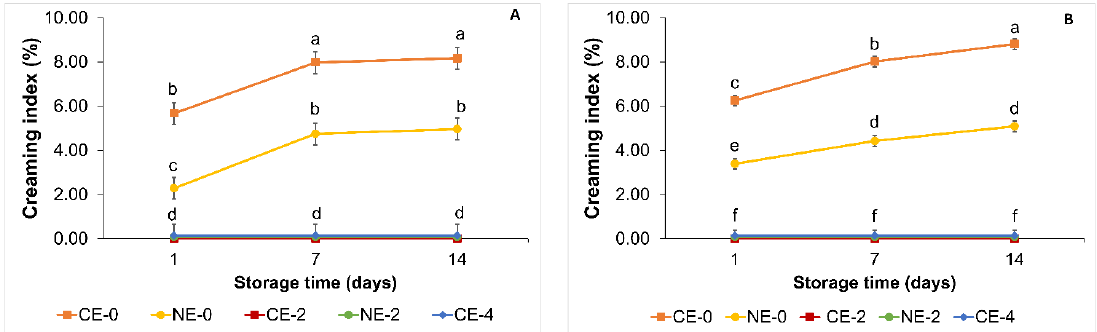
( A ) 4 ◦ C and ( B ) 20 ◦ C (mean values and 95% HSD confidence intervals). Conventional emulsion Figure 4. Dynamic moduli as a function of frequency of emulsions and butter . Conventional Figure 4. Dynamic moduli as a function of frequency of emulsions and butter . Conventional Figure 4. Dynamic moduli as a function of frequency of emulsions and butter . Conventional Figure 4. Dynamic moduli as a function of frequency of emulsions and butter . Conventional Figure 4. Dynamic moduli as a function of frequency of emulsions and butter . Conventional ( A ) 4 °C and ( B ) 20 °C (mean values and 95% HSD confidence intervals). Conventional emulsion ). Nanoemulsion (NE-0 ). Values with different superscript letters emulsion (CE-0 ; CE-2 ; CE-4 ). Nanoemulsion (NE-0 ; NE-2 ). Filled symbols corre- emulsion (CE-0 ; CE-2 ; CE-4 ). Nanoemulsion (NE-0 ; NE-2 ). Filled symbols corre- emulsion (CE-0 ; CE-2 ; CE-4 ). Nanoemulsion (NE-0 ; NE-2 ). Filled symbols corre- emulsion (CE-0 ; CE-2 ; CE-4 ). Nanoemulsion (NE-0 ; NE-2 ). Filled symbols corre- ). Nanoemulsion (NE-0 ; NE-2 ). Values with different superscript emulsion (CE-0 ; CE-2 ; CE-4 ). Nanoemulsion (NE-0 ; NE-2 ). Filled symbols corre- letters are significantly different ( p < 0.05). spond to elastic modulus (G’) and open symbols to viscous modulus (G”). spond to elastic modulus (G’) and open symbols to viscous modulus (G”). spond to elastic modulus (G’) and open symbols to viscous modulus (G”). spond to elastic modulus (G’) and open symbols to viscous modulus (G”). are significantly different ( p < spond to elastic modulus (G’) and open symbols to viscous modulus (G”).